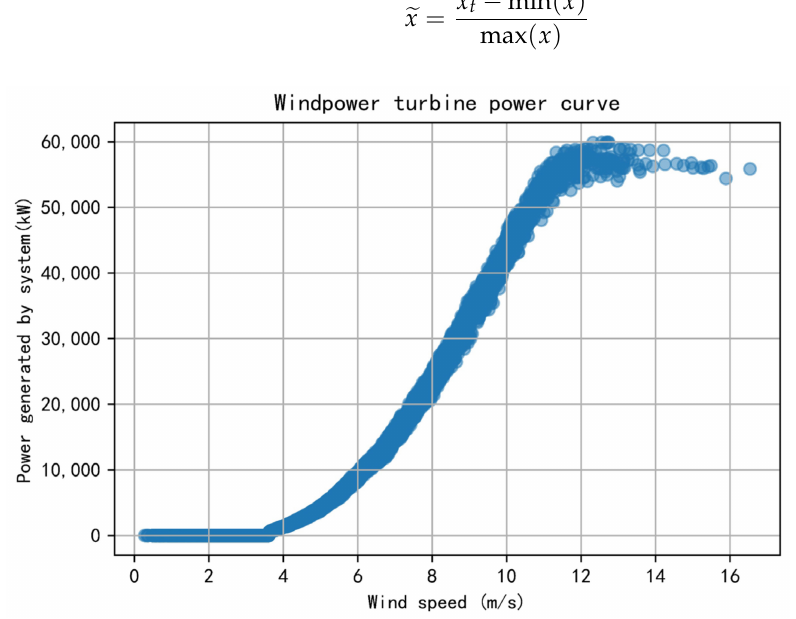
Figure 8. Historical data of the turbine power.